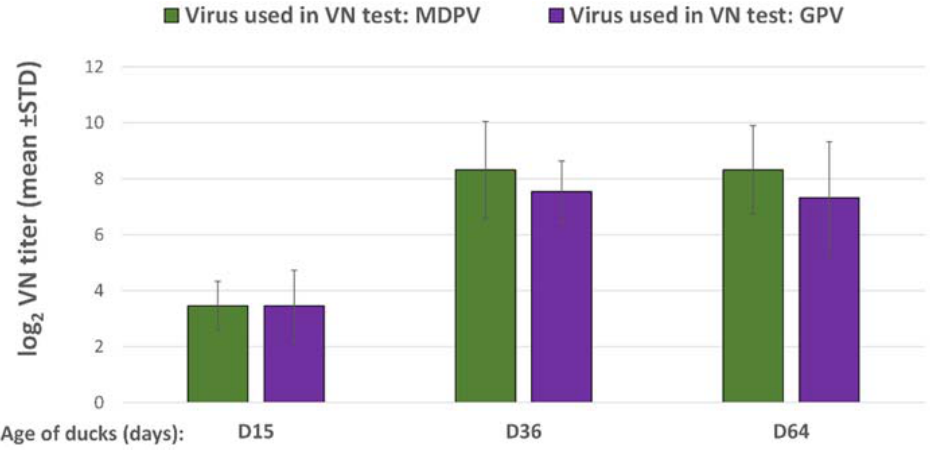
Figure 4. Antibody response of MD ‐ free Muscovy ducks to the bivalent vaccine (log 2 VN titer). The results of clinical observation after the challenge with GPV and MDPV are pre- sented in Table 5. Table 5. Efficacy of bivalent vaccine in MDA ‐ free Muscovy ducks—Protection against challenge.